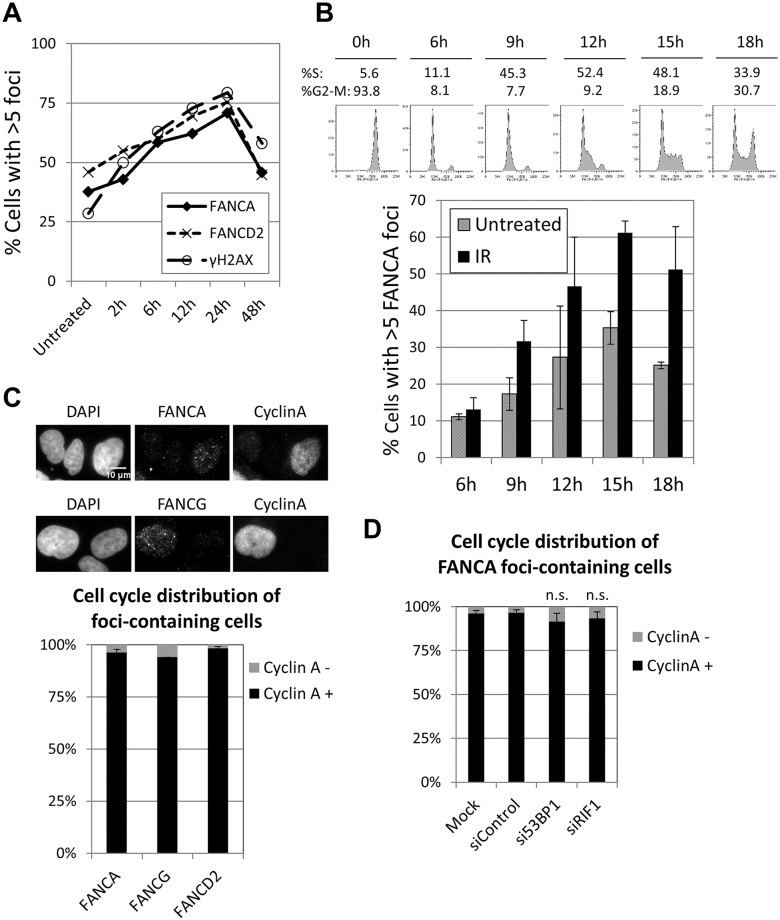
FA core complex foci form during S-G2 phases of the cell cycle.(A) U2OS cells were treated with MMC for 1h at 60ng/ml, then released into fresh media and fixed at the indicated time points. Cells were immunostained with the indicated antibodies and quantified. The percentage of cells with more than 5 foci is shown. (B) Cells were arrested in M-phase with nocodazole, re-seeded in fresh media and collected at the indicated times. The upper panel shows cell cycle profiles (PI staining). The lower panel shows percentage of cells with more than 5 FANCA foci (n = 3, mean ± SD). Cells were untreated or irradiated with 10Gy IR 1h before each time point. (C) Cells were irradiated with 10Gy IR 2h before fixation. Graph shows percentage of cyclin A-positive and -negative cells in the FANCA-, FANCG- or FANCD2-foci containing cells population (n = 3, mean ± SD). Upper panel shows representative images. (D) Cells were transfected with indicated siRNAs and irradiated with 10Gy IR 2h before fixation. Graph shows percentage of cyclin A-positive and -negative cells in the FANCA-foci containing cells (n = 3, mean ± SD).